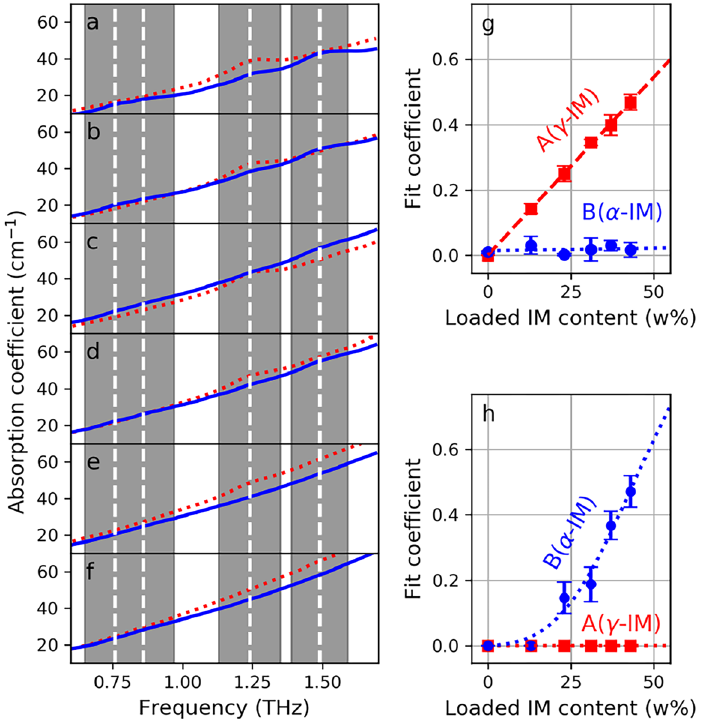
Figure 2. ( a – f ) show the spectra of the smartFilms (continuous blue) and physical mixtures (dotted red) samples for IM concentrations of 43, 37, 31, 23, 13, 0 w%, respectively. Fit coefficients A (red squares) and B (blue circles) as a function of concentration for physical mixture samples ( g ) and for smartFilm samples ( h ). Coefficients A and B correspond to the γ -IM and α -IM, respectively. The dashed red line in ( g ) represents the linear fit and the dotted lines in ( g – h ) serve as a